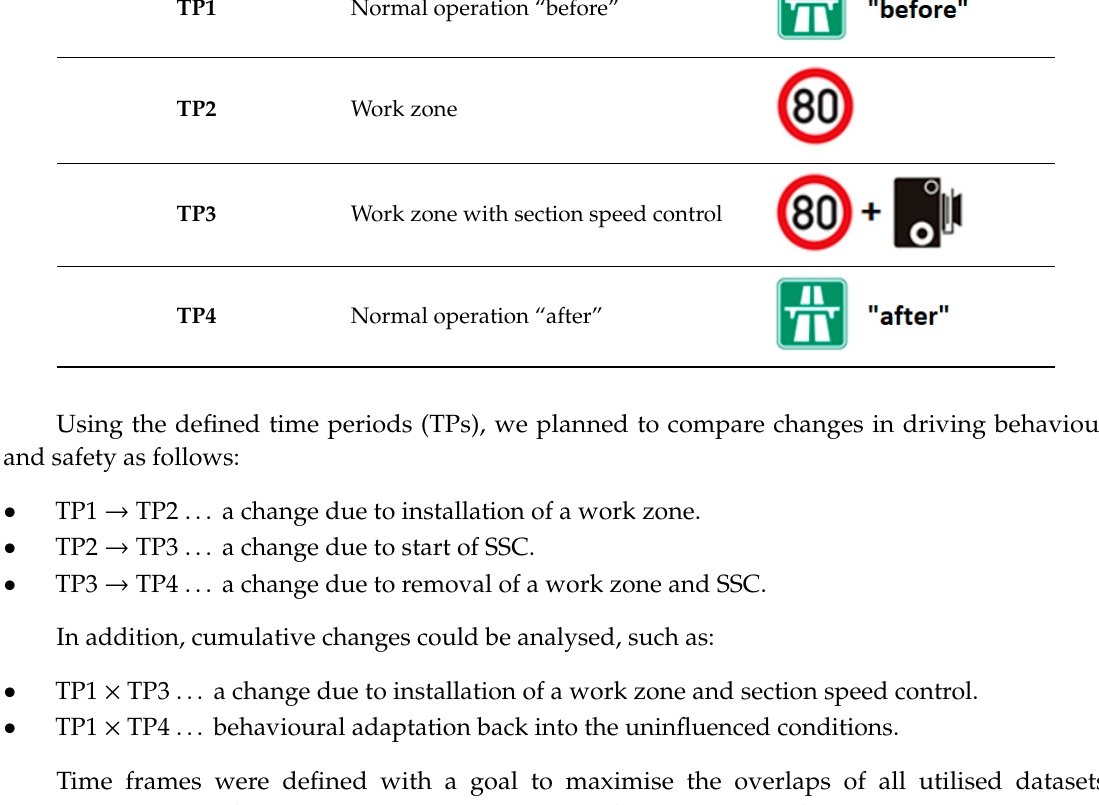
TP1 Normal operation “before”